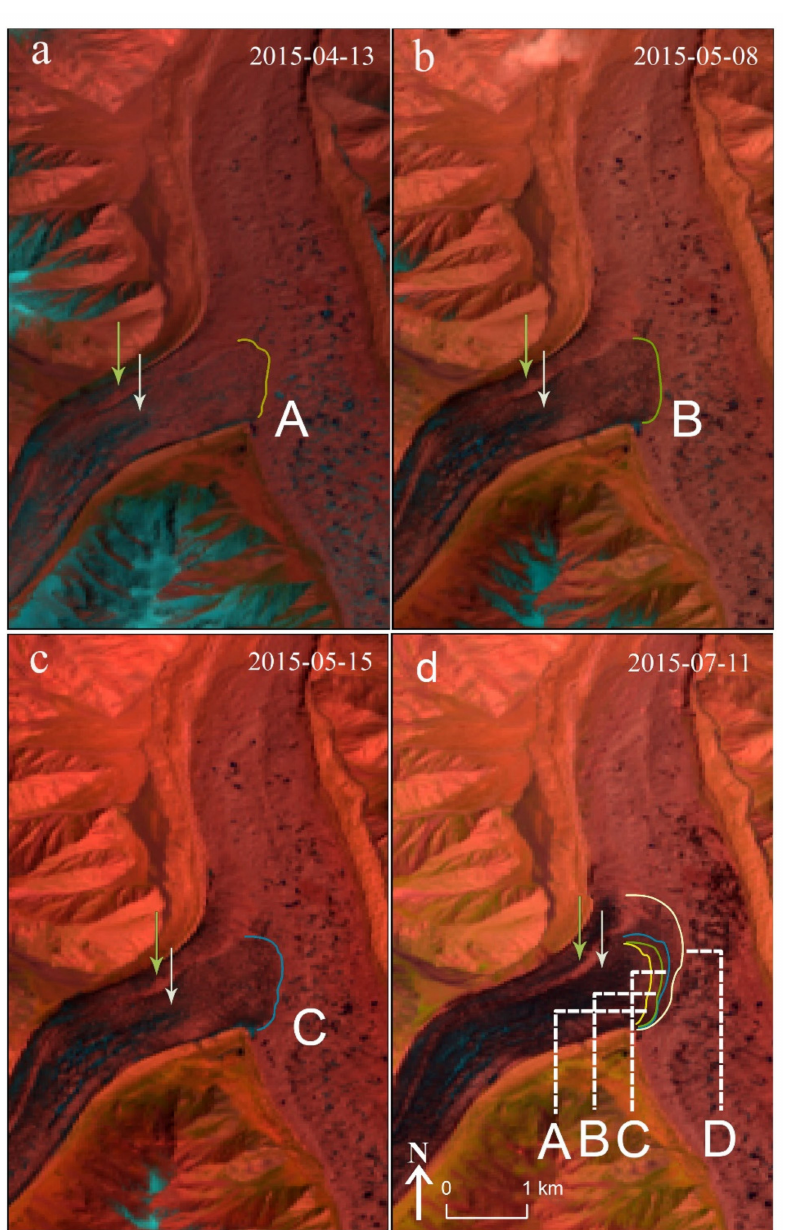
Figure 8. Panel ( a – d ) show the confluence of the west branch of Karayaylak glacier and the main glacier on 13 April, 8 May, 15 May and 11 July 2015. The background image is Landsat 8. A, B, C, D in the figure note the west tributary terminus location in multiple